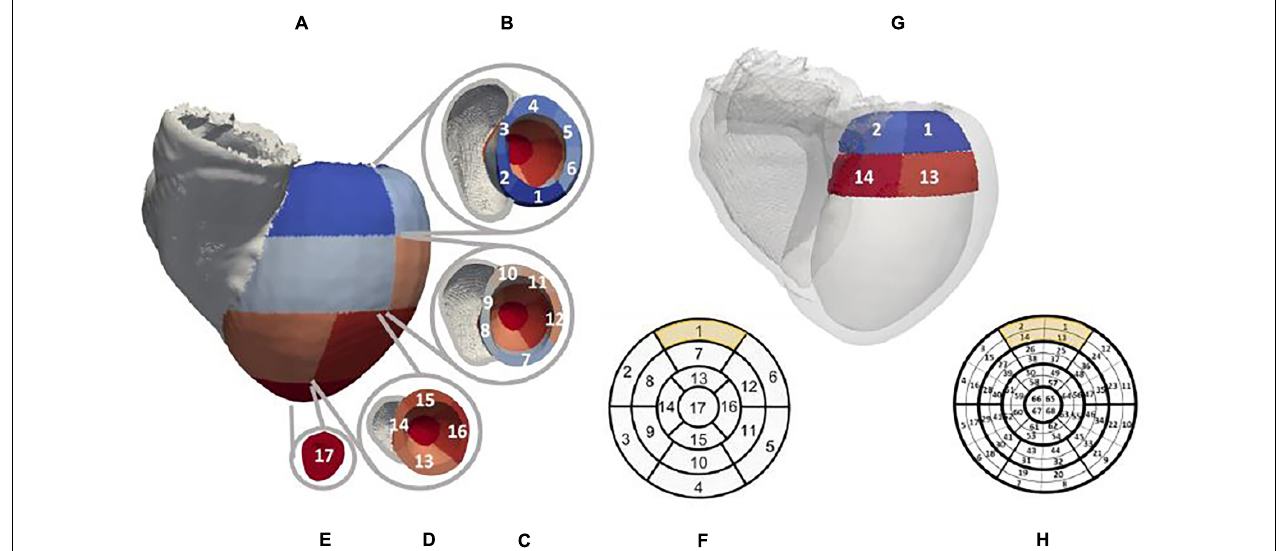
FIGURE 2 | Patient-specific LV segment models. Generic AHA 17-segment model is shown in (F) . The equivalent patient-specific model of the LV mesh is shown in (A) with basal, mid, and apical segments illustrated in (B–E) , respectively. An example of the novel 68-segment model is shown in (H) highlighting the equal division in four parts of each of the 17 segments. (G) shows an example of how segment 1 in our mesh was divided into four equal